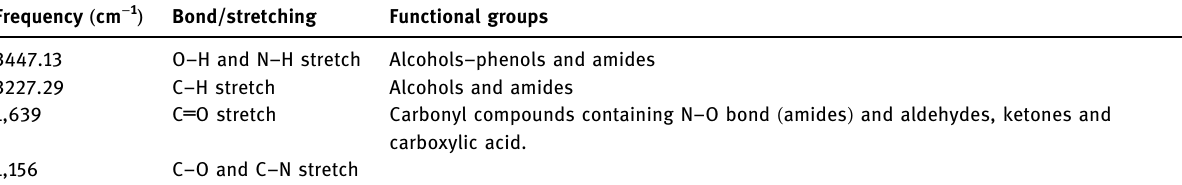
Table 1: FT - IR of Ag -